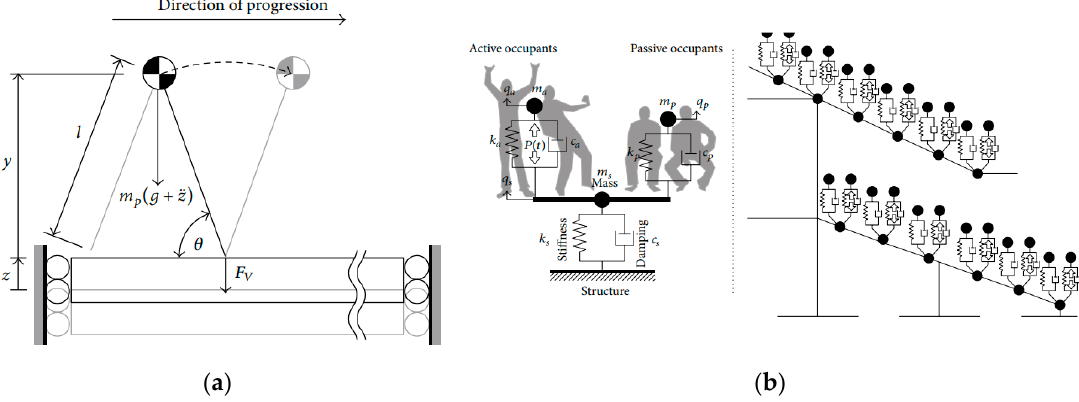
Figure 4. Mathematical models for human-structure interaction (HSI) calculations of pedestrian structures: ( a ) Inverted pendulum approach and ( b ) crowd effects on stadium structures. Figures reproduced from [18] under CC BY 4.0 license.